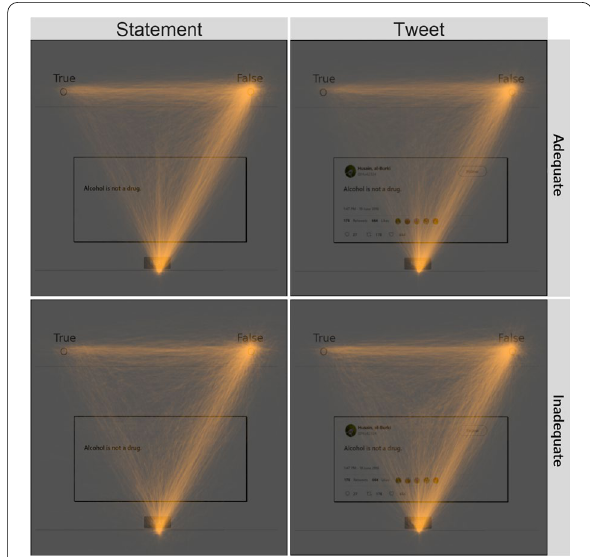
Fig. 2 Heat maps of mouse movements by experiment and health literacy. Heat maps are shown for statements used in Experiment 1 (left panels) and tweets in Experiment 2 (right panels). The heat maps show incremental processing for many trials (i.e., there are smooth paths from the start button to the response button). However it is also apparent that overrides exist in the data (i.e., abrupt changes occur, especially near the response buttons). These overrides indicate that dual stage processing may happen late in the trials